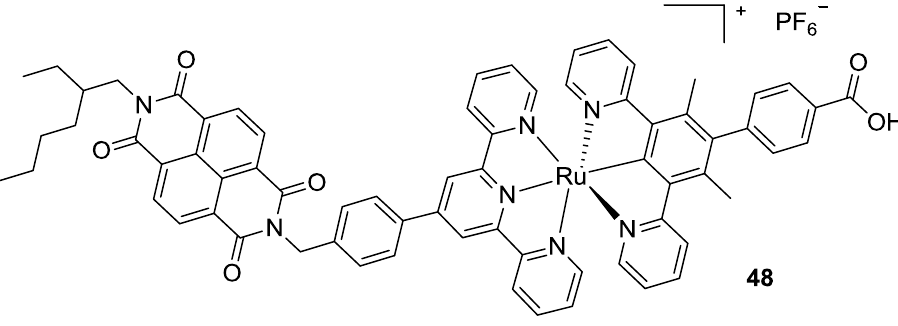
Figure 39. NDI-Tpy proposed by Ji et al. [161].